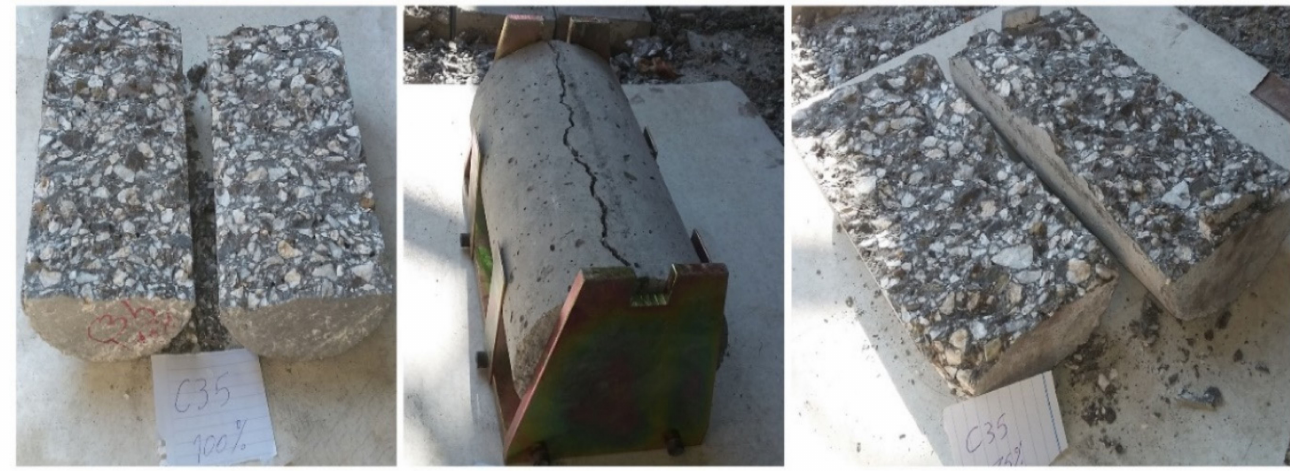
Figure 11. The dominant failure mode for cylindrical